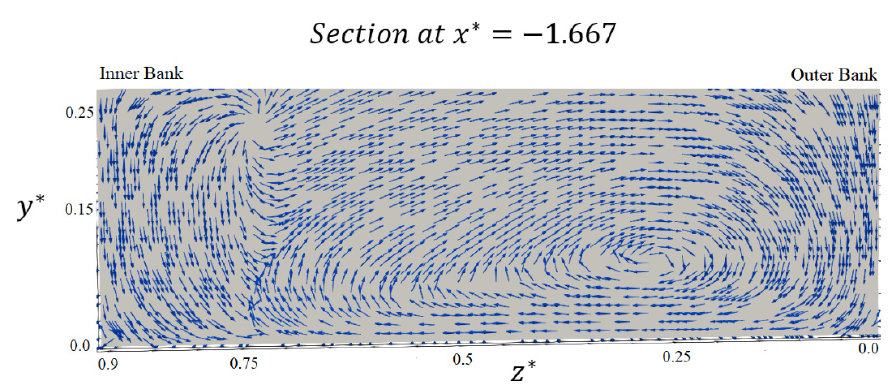
Figure 18. The vectors of velocity at section x* = − 1.667 (Standard k- ε ).